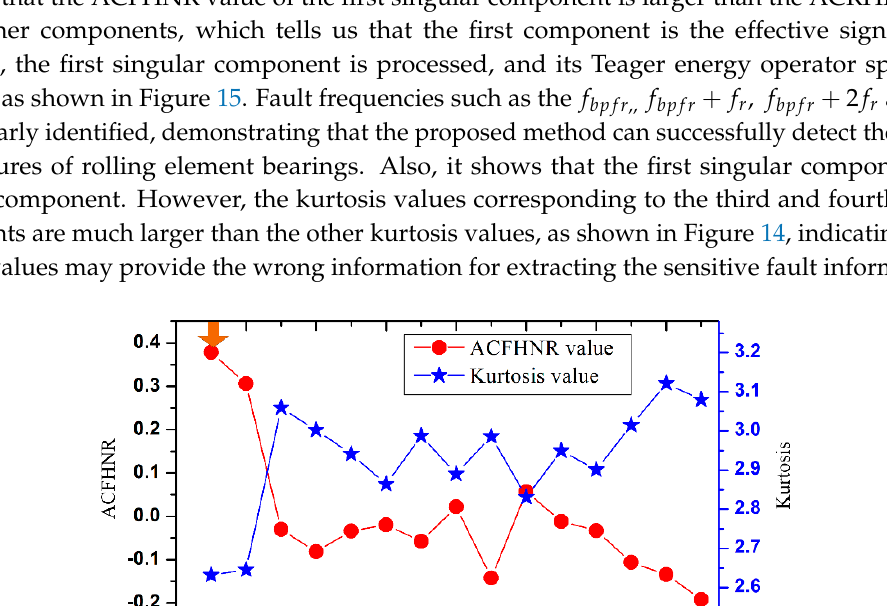
Figure 13. The original signal and the envelope spectrum of ball fault 1.( a ) The raw fault signal ; ( b ) The envelope spectrum of the raw fault signal.